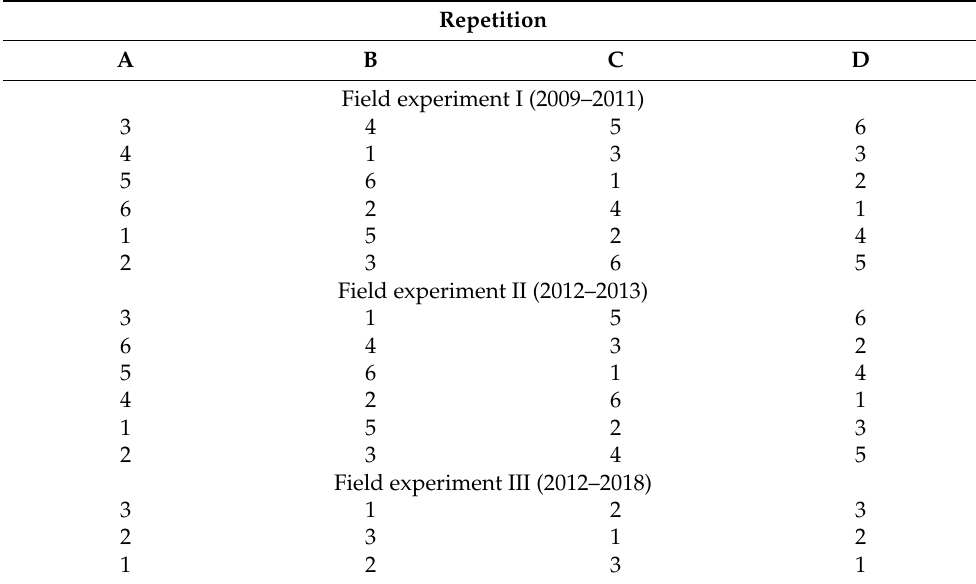
Table 2. Schematic of the distribution of test sites in the field experiments.